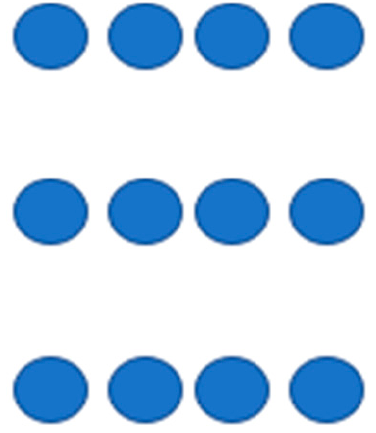
Figure 2. The points in a 3 × 4 array.